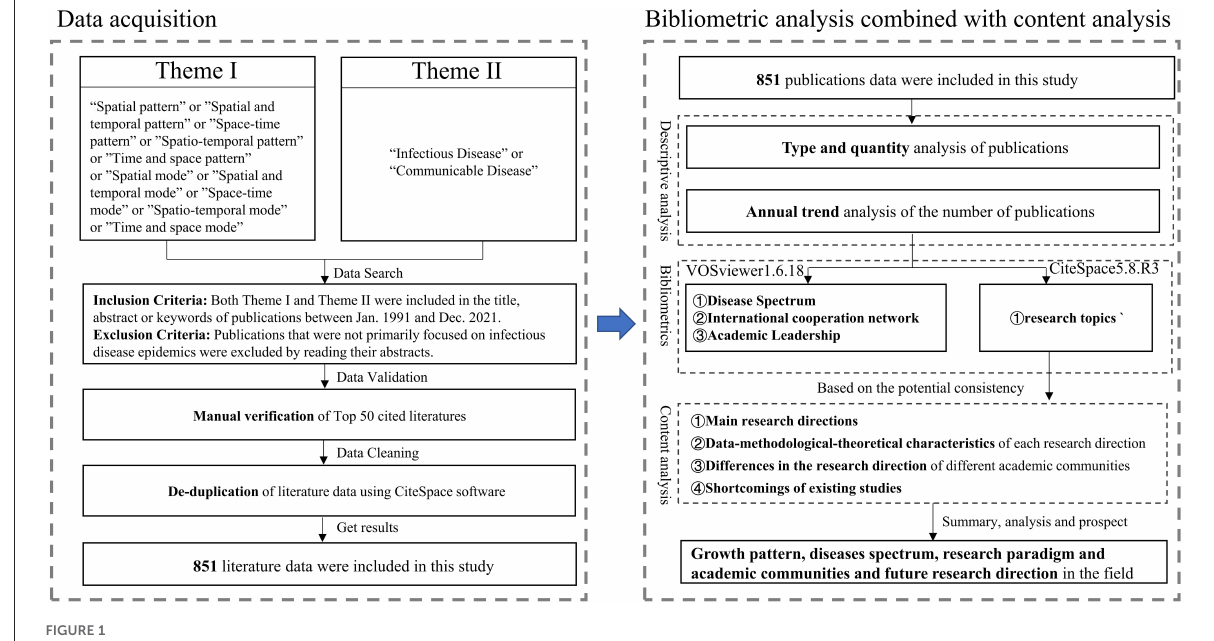
FIGURE1 Research